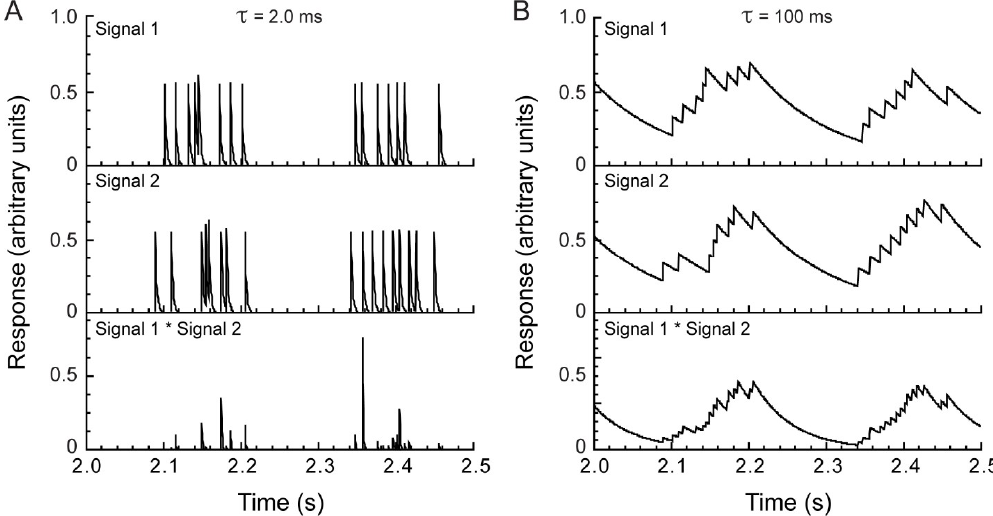
Figure 2. Temporal integration improves correlation detection. ( A ) A short integration time (2 ms) yielded little overlap between two spike responses evoked by repeated presentation of the same stimulus (top, middle). Only highly coincident spikes (temporal deviation < ~4 ms) resulted in non-zero output (bottom). ( B ) A long integration time (100 ms) yielded substantial overlap between the two input signals and resulted in a strong output signal (bottom).